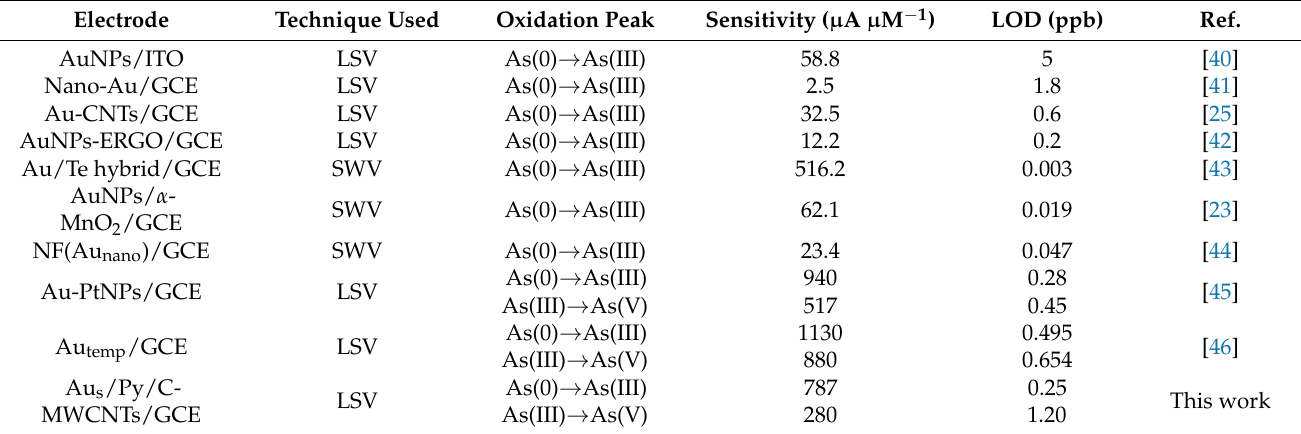
Figure 6. ( A ) Dual-signal LSASV response on Au s /Py/C-MWCNTs/GCE in 0.1 M aqueous H 2 SO 4 containing As(III) at different concentrations; ( B ) the associated calibration curves. E D = − 0.40 V, t D = 7 min, scan rate: 5 V s − 1 . Table 1. Comparison of the analytical performance of Au and Au-based electrodes for ASV assay of As(III).